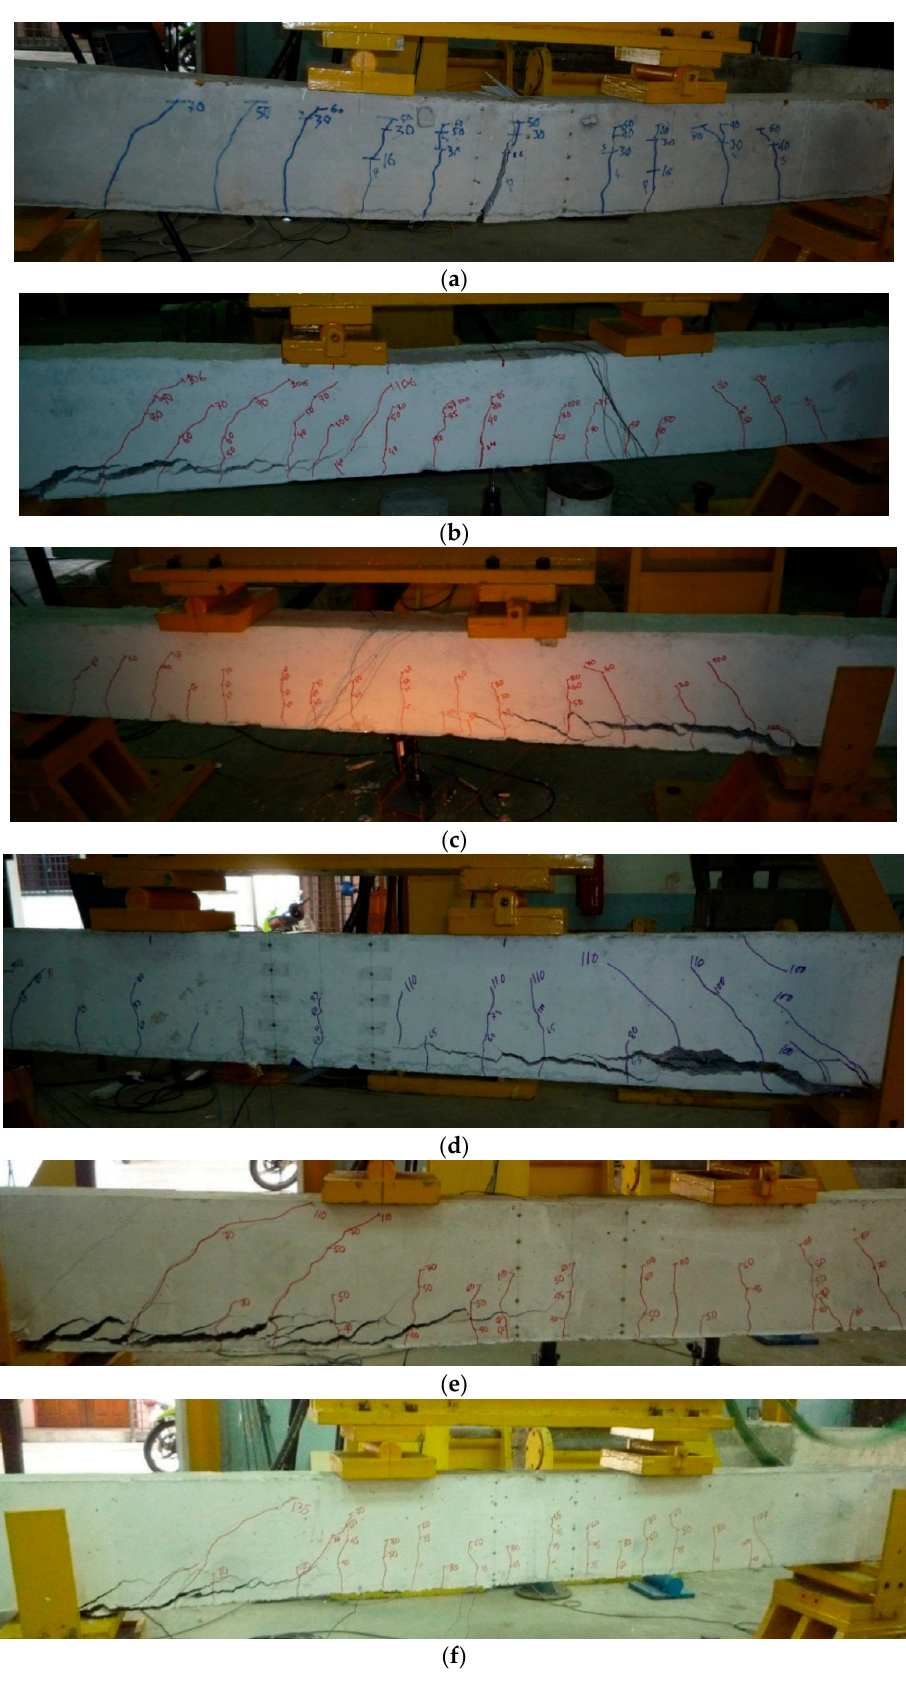
Figure 5. Modes of failure of all beams. ( a ) CB; ( b ) N-1; ( c ) N-2; ( d ) N-3; ( e ) N-4; and ( f ) N-5.